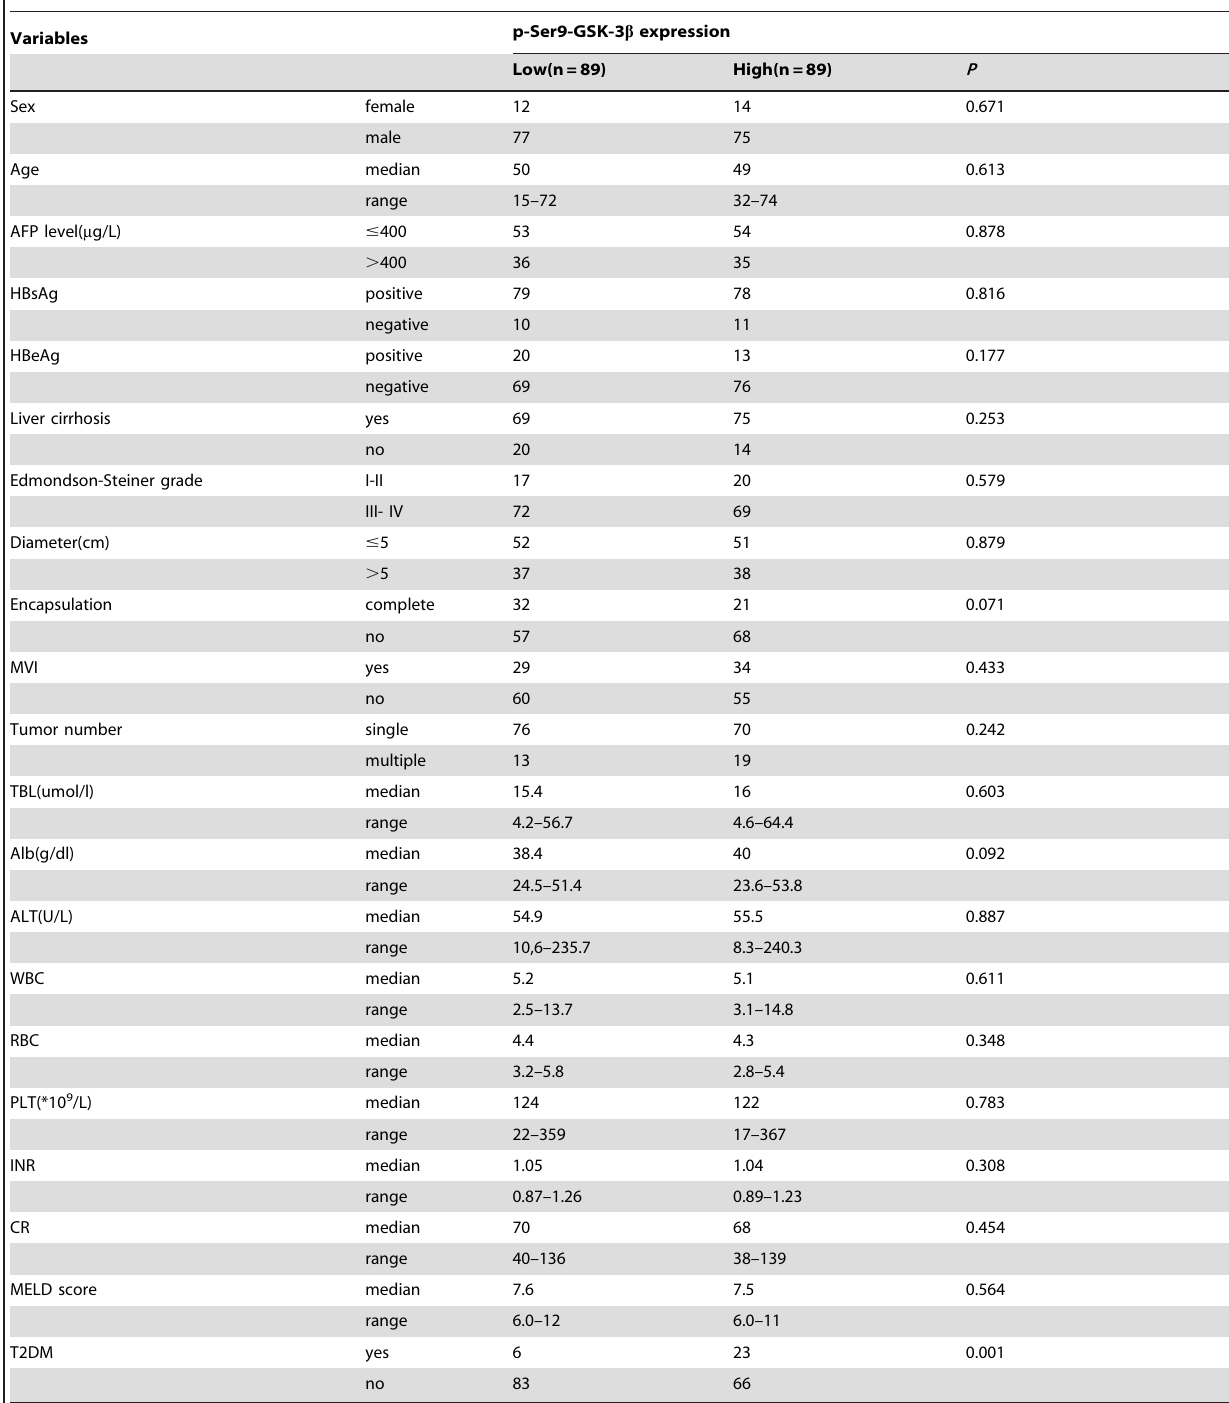
Table 1. Correlation between p-Ser9-GSK-3 b expression and clinicopathologic features.